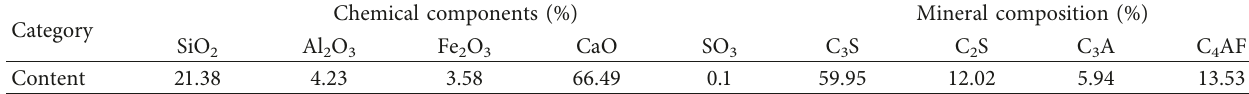
Table 1: The chemical component and mineral composition of ordinary silicate cement.